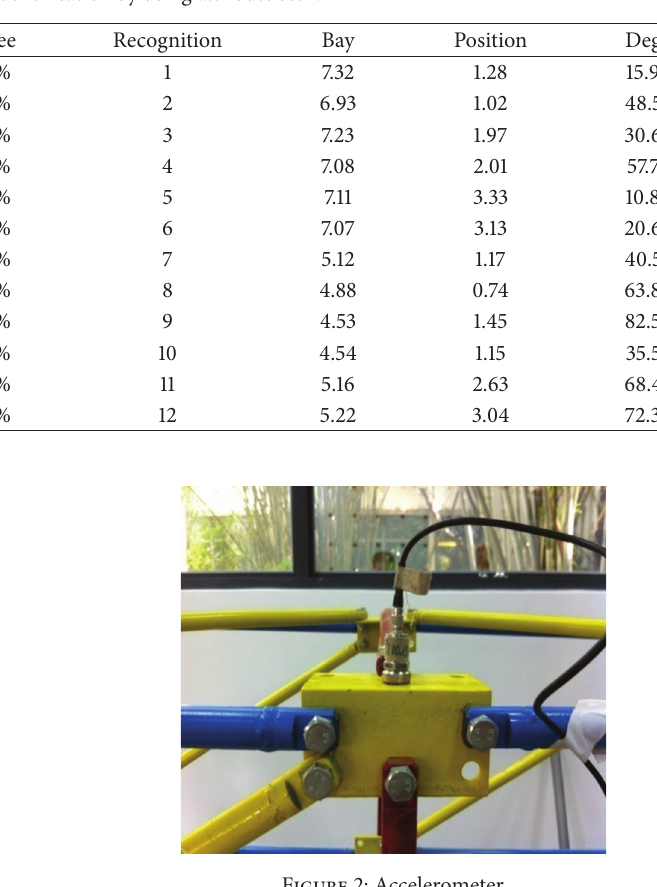
Table 13: Damage identification by using attribute set 1.